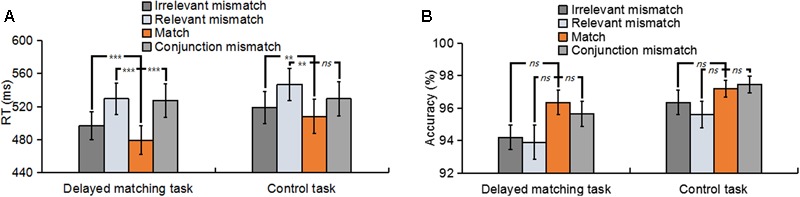
(A) The mean reaction times for Irrelevant-mismatch, Relevant-mismatch, Match, and Conjunction-mismatch conditions in both the delayed matching task and the control task. (B) The mean accuracies for Irrelevant-mismatch, Relevant-mismatch, Match, and Conjunction-mismatch conditions in both the delayed matching task and the control task. The error bars represent standard errors (SEs), and asterisks mark significant differences between the match condition and other three types of mismatch conditions. ns: non-significant; ∗p < 0.05; ∗∗p < 0.01; ∗∗∗p < 0.001.